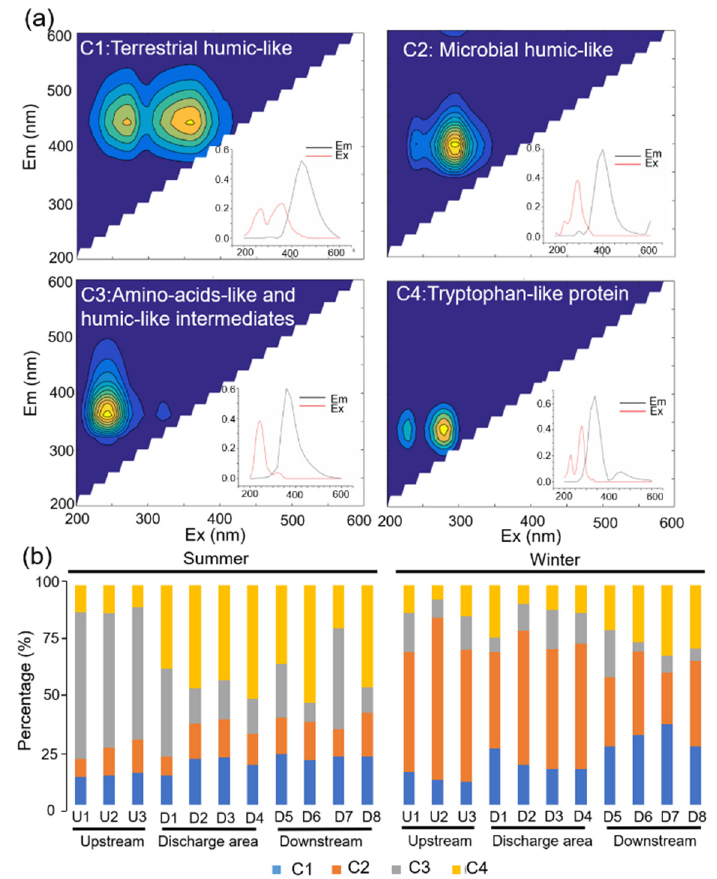
Figure 2. ( a ) Four main components of the spectrum identified by parallel factor analysis (PARAFAC). Insets visualize the excitation and emission loadings of the four components and ( b ) the relative percentages of each component based on F max